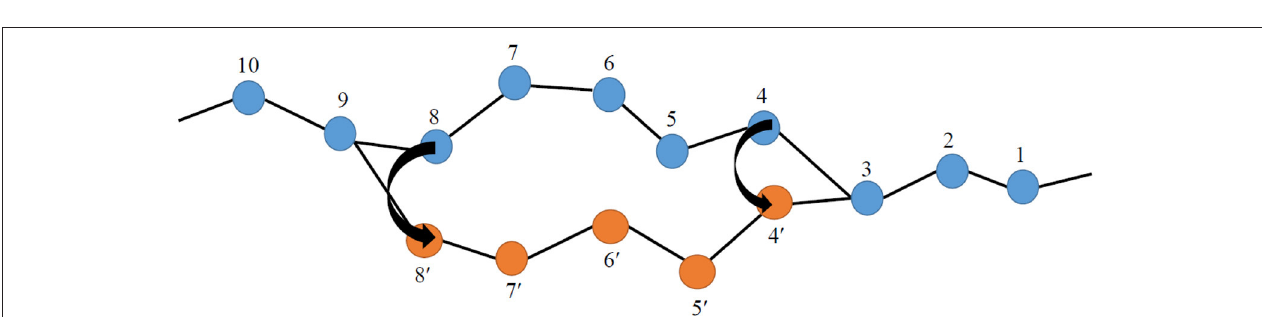
FIGURE 3 | Schematic illustration of the ConRot Monte Carlo move for polymer simulations in continuous space.